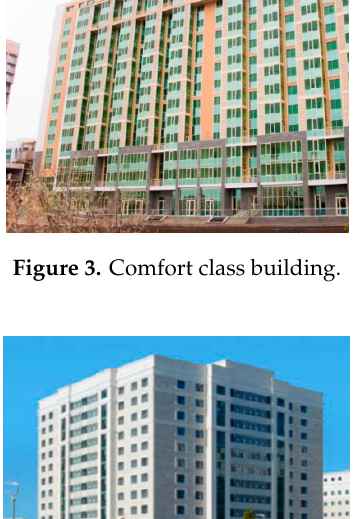
Figure 3. Comfort class building.